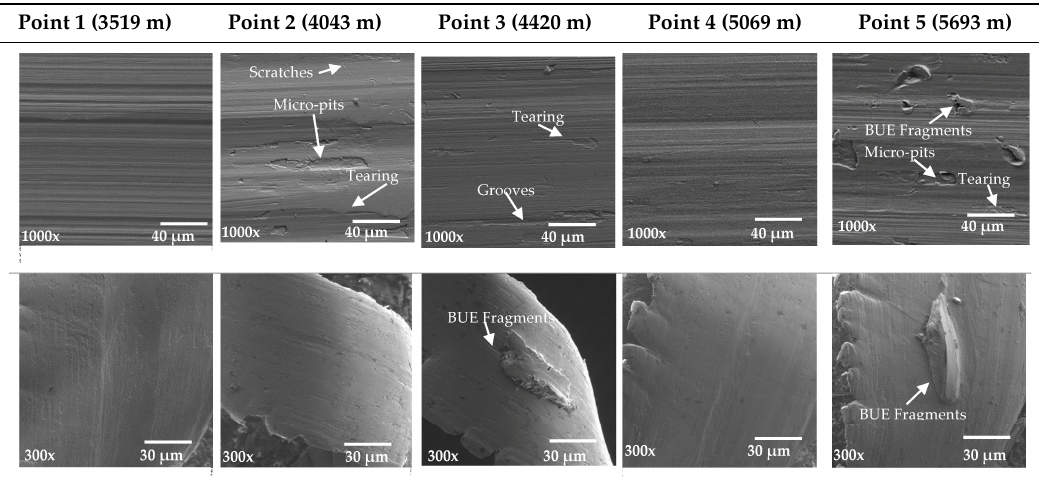
Table 4. Machined surface and chip undersurface of five selected points in the steady state